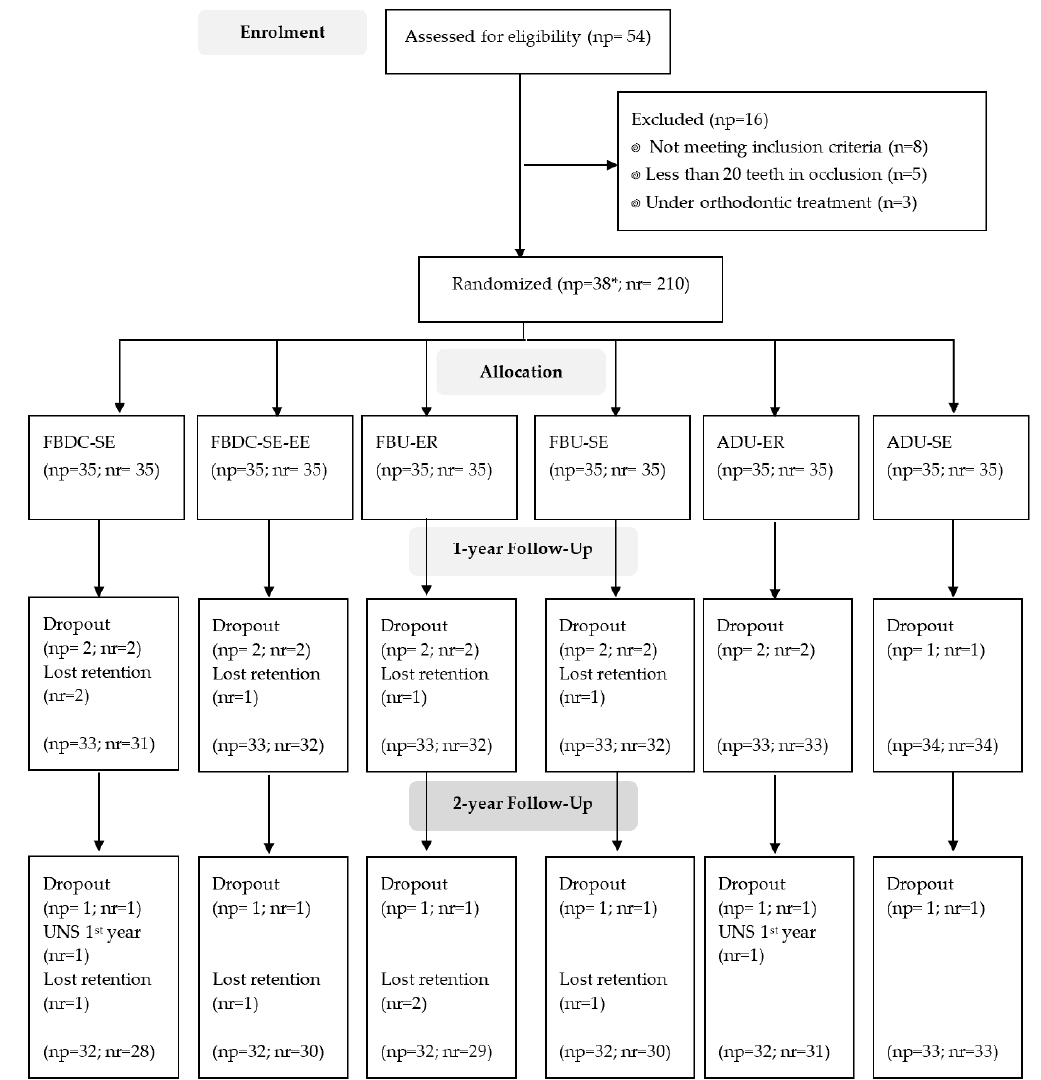
Figure 1. Research Flow chart of participants/NCCLs enrolled, followed, and analysed. np: number of participants; nr: number of restorations; SE: self-etch. SE-EE: self-etch with selective enamel etching; ER: etch-and-rinse; FBDC: Futurabond DC; FBU: Futurabond U; ADU: Adhese Universal; UNS: scored clinically unsatisfactory. * Each participant was enrolled in several arms and could receive at least 1 up to 6 NCCLs restorations. Table 2. All participants’ and NCCL restorations’ characteristics, counts (n), and percentages (%) at baseline, allocated to the control (FBDC-SE; FBDC-SE-EE) and study (FBU and ADU) groups.